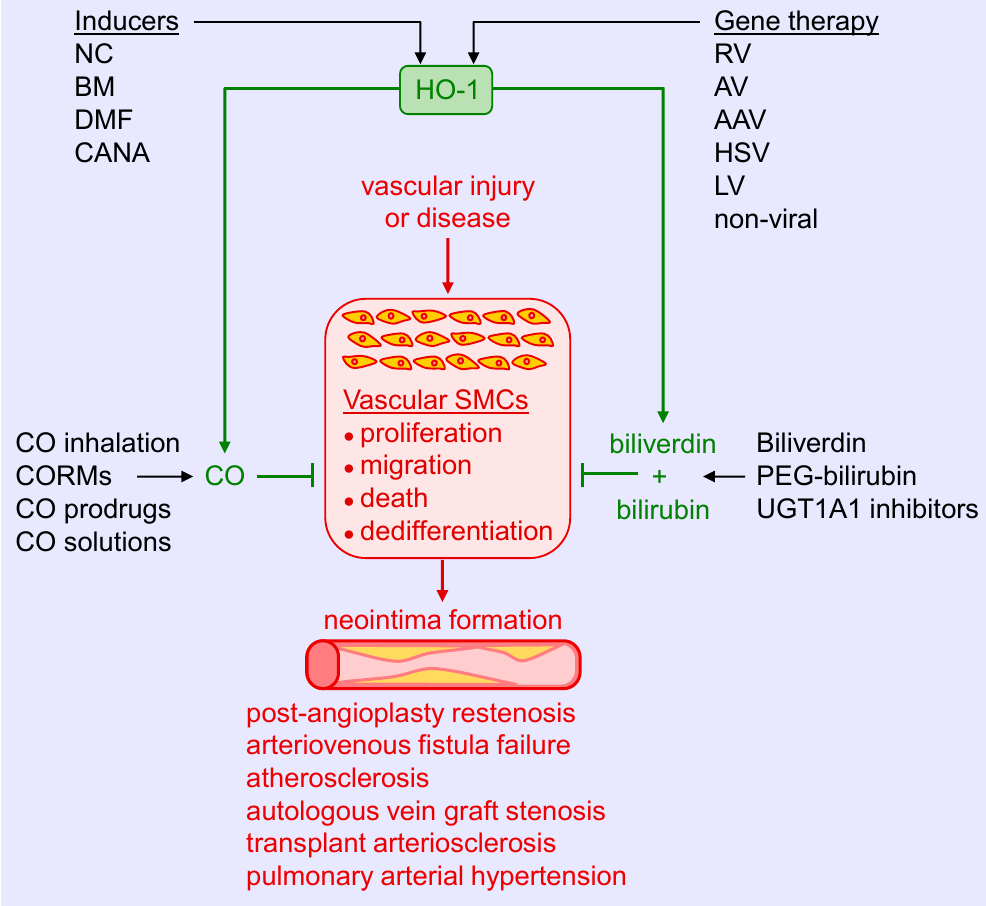
Figure 5. Targeting heme oxygenase-1 (HO-1) and its products in arterial remodeling. Arterial injury or disease triggers the proliferation, migration, death, and dedifferentiation of vascular smooth muscle cells (SMCs), leading to the formation of a neointima. Several strategies may be used to harness the therapeutic potential of HO-1 to block SMC activation and neointima formation in various pathologies. Pharmacological inducers, including nutraceuticals (NC), bardoxolone methyl (BM), dimethylfumurate (DMF), and canagliflozin (CANA), provide a promising approach in stimulating HO-1 expression. Similarly, gene therapy using retroviruses (RV), adenoviruses (AV), adeno-associated viruses (AAV), herpes simplex virus (HSV), lentivirus (LV), or non-viral methods represents an attractive mode of delivering HO-1 to tissues. Alternatively, CO can be administered via gas inhalation or through the use of CO-releasing molecules (CORMs), prodrugs that generate CO, and aqueous solutions of CO. In addition, biliverdin or pegylated bilirubin (PEG-bilirubin) may be directly administered, or pharmacological inhibitors of uridine 5 ′ -diphopho-glucuronlytransferase 1A1 (UGT1A1) alone, or in combination with HO-1 inducers, may be utilized to increase circulating levels of bilirubin.